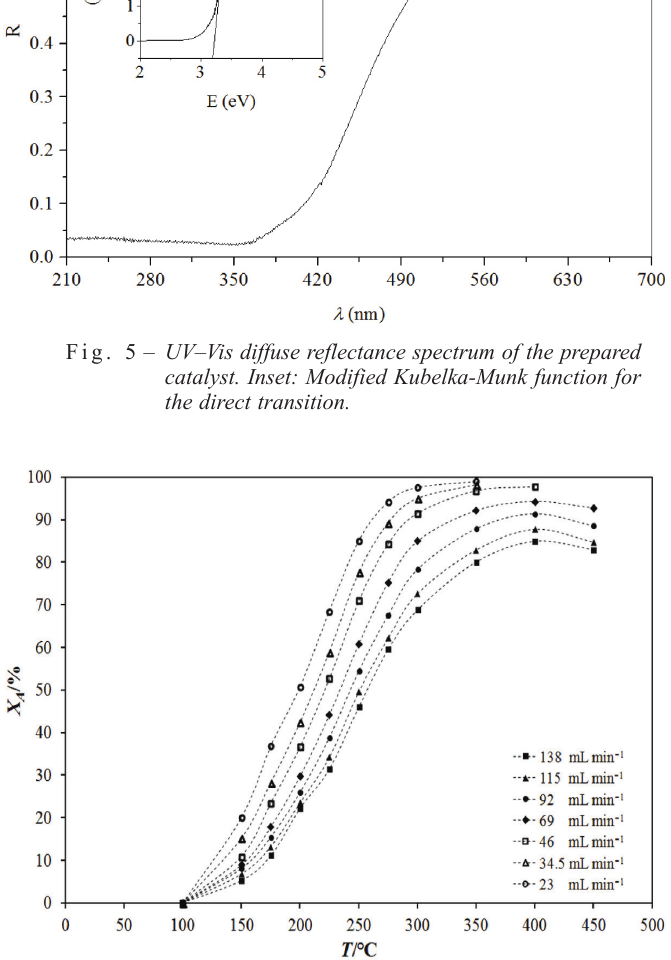
Fig. 6 – Influence of temperature and total flow rate of the reaction mixture on toluene conversion over CeO